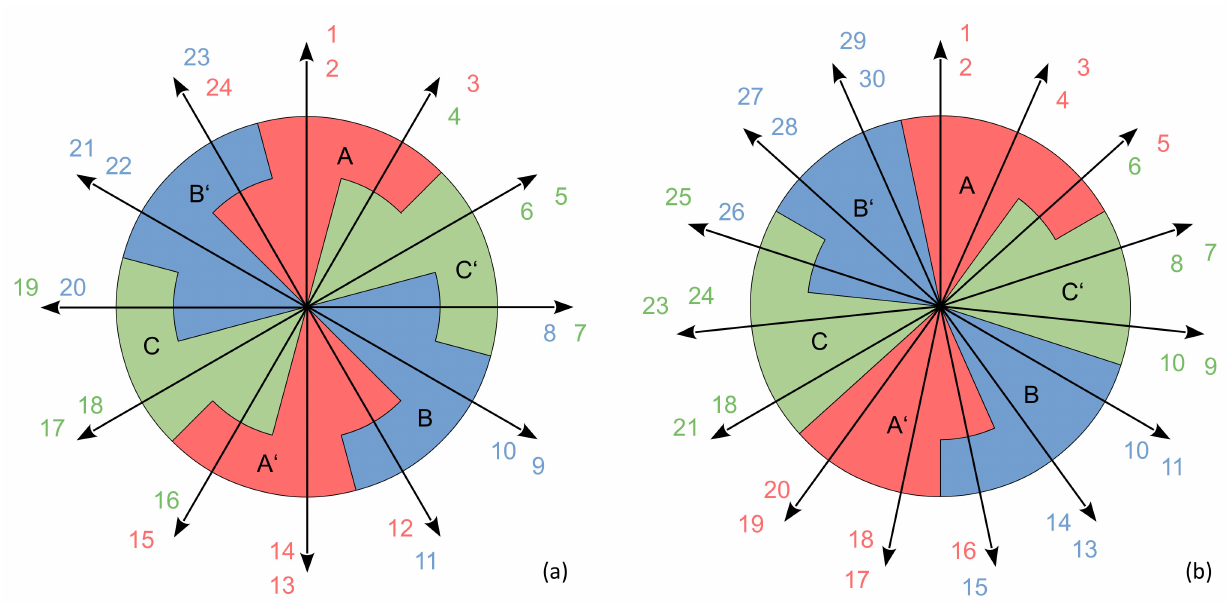
Figure 3. Star of slot phasors, numbered coil sides, and colored phase belts of three-phase winding with q = 2 and winding step y 1 s = 5 ( a ), and q = 5/2 and winding step y 1 s = 7 ( b